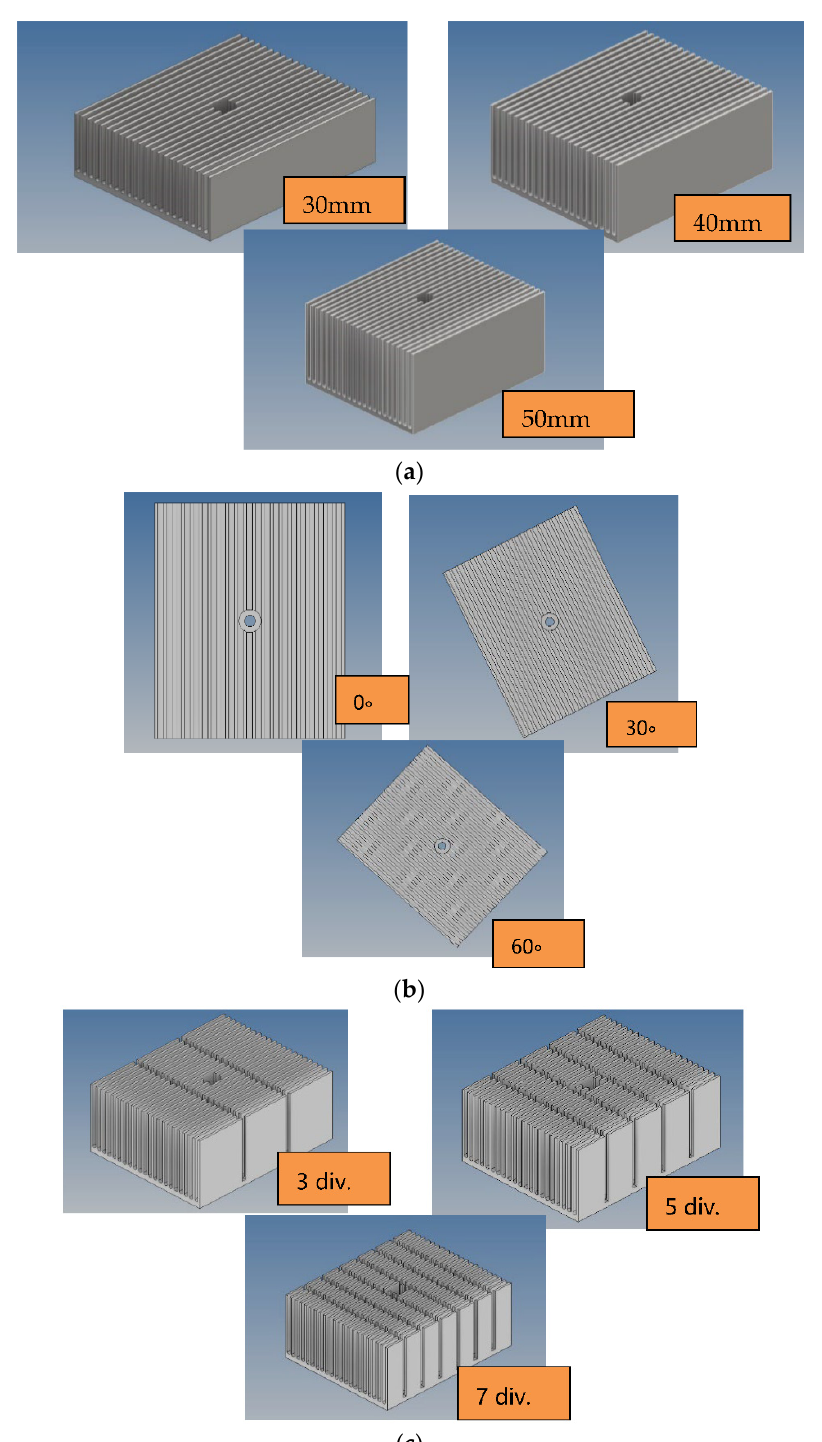
Figure 5. ( a ) Fin height, ( b ) heat sink angle, ( c ) fin aliquots. Finding the impact of a particular factor’s magnitude requires regression analysis. As indicated in Table 4 for the field synergy angle and Table 5 for the average fin temperature, if ( p < 0.05), the factor could be eliminated and the RSM could be